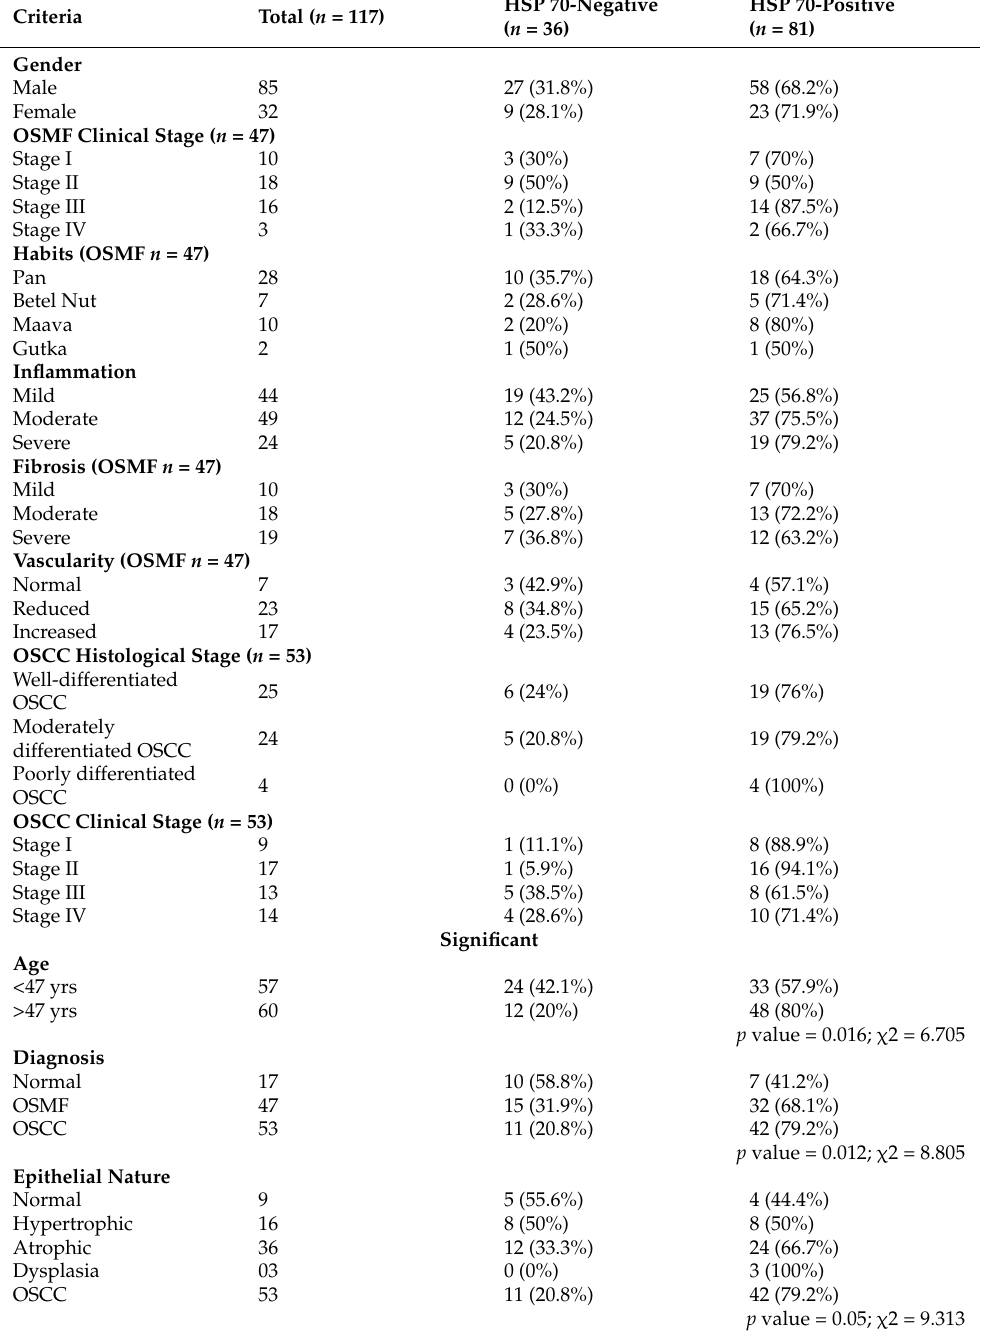
Table 5. Clinical histopathological features in HSP 70-positive and -negative groups of OSMF, OSCC and normal